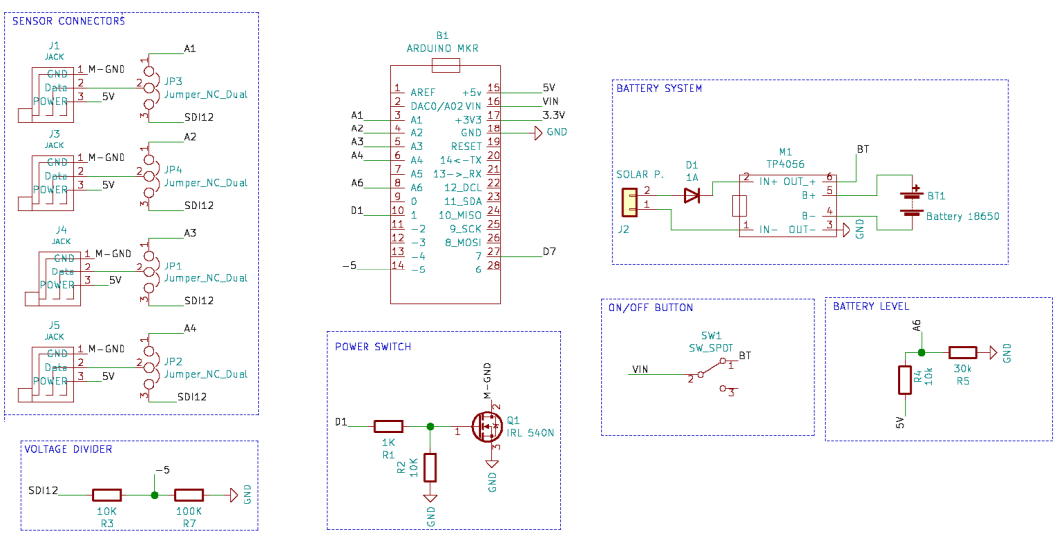
Figure 3. Device Figure 3. Device Schematic.